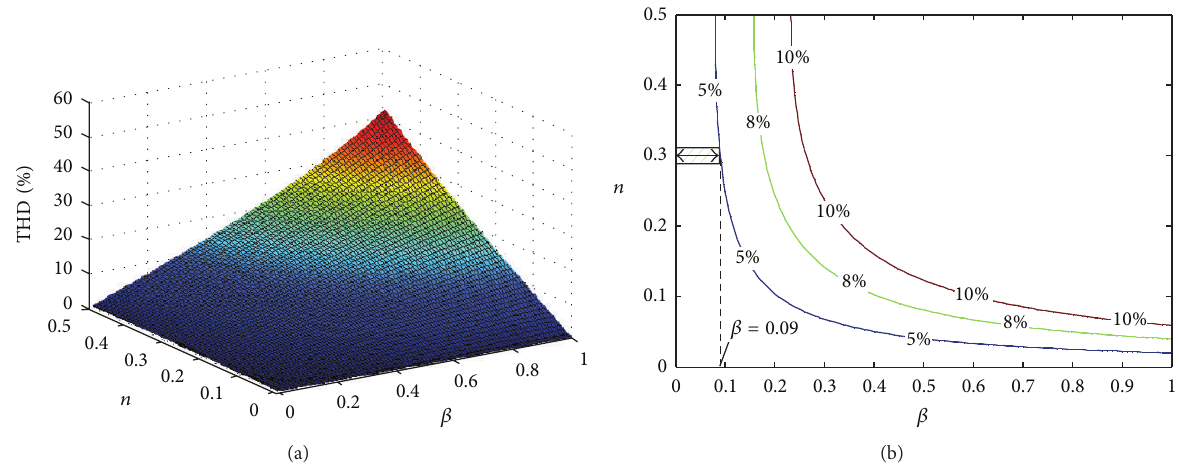
Figure 2: Three-dimensional mesh and contour lines of total current harmonic distortion. (a) Three-dimensional mesh. (b) Contour lines.